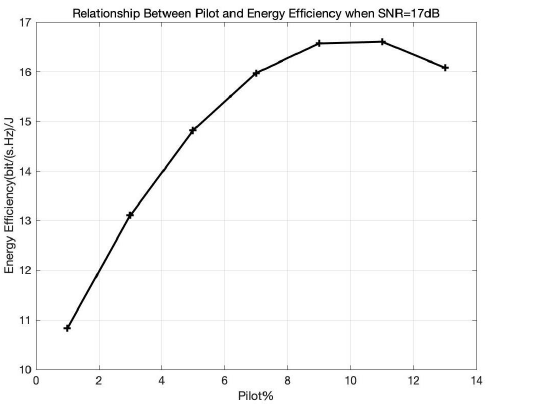
Figure 11. Relationship Between Pilot and Energy Efficiency when SNR = 17